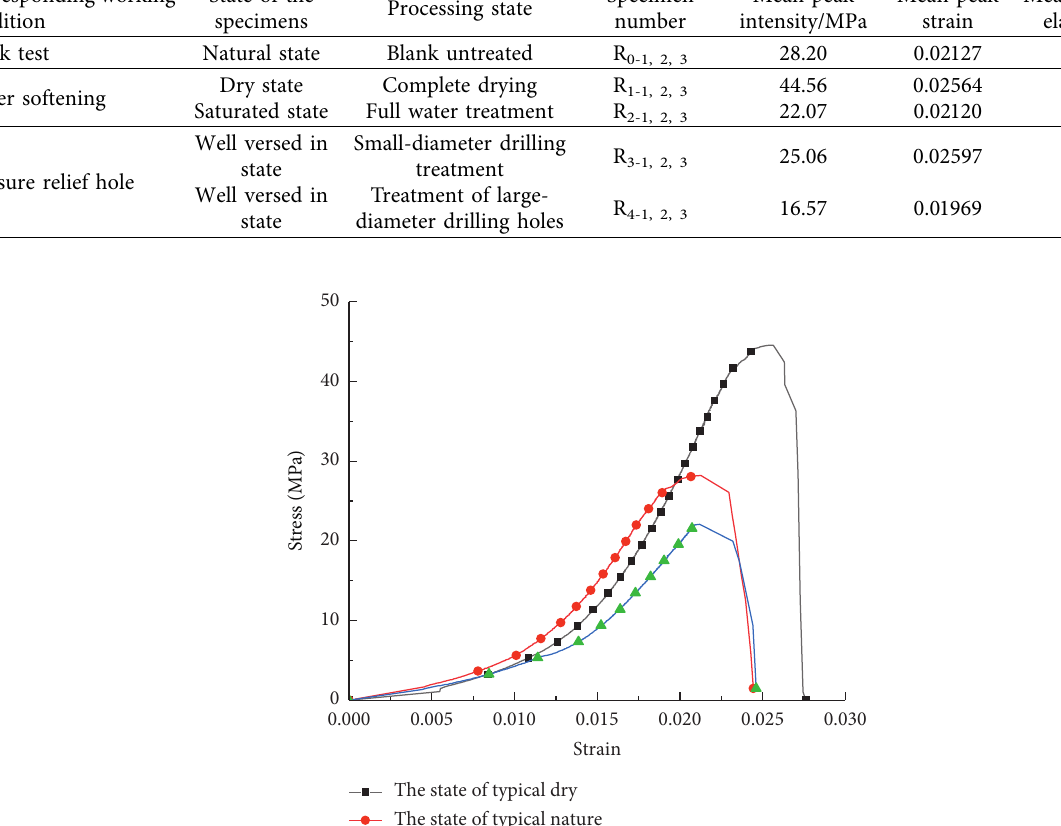
Table 3: Average mechanical parameters of rock samples with strong bursting liability under different modification states. Corresponding working